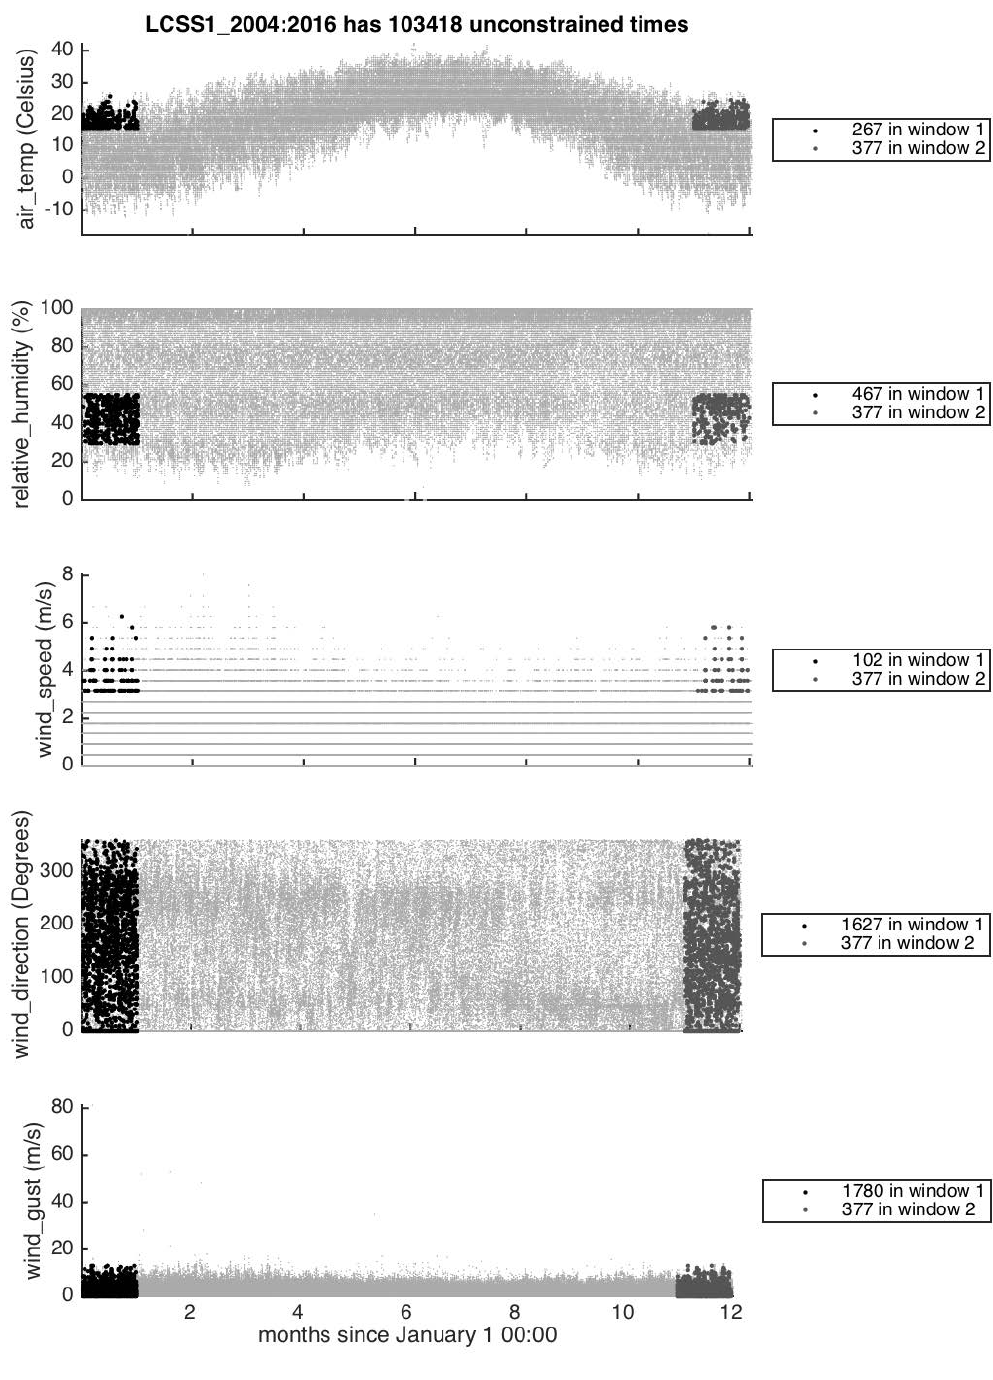
Figure A3. Station data (vertical) vs. month number (horizontal) for station LCSS1 (Savriv, 33.33305° N, 81.591667° W, 275 ft in South Carolina) from 2004 to 2016. Points that do and do not meet the burn-requirements (Table 2) are dark and light gray, respectively, and enumerated in the legends and titles, respectively. The abscissa is t ( mod 12 ) for all the years indicated in the